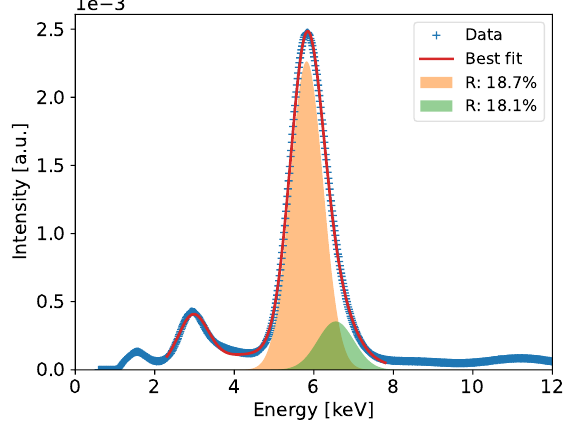
Figure 9. GEM detector B . Gas gain and energy resolution vs. detector bias voltage.